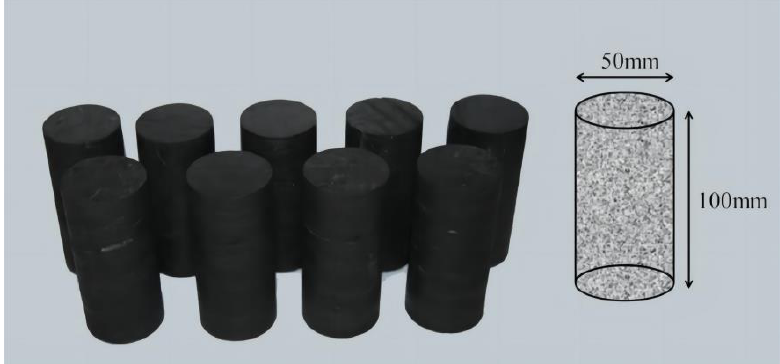
Figure 1. Partial test coal specimens after processing.